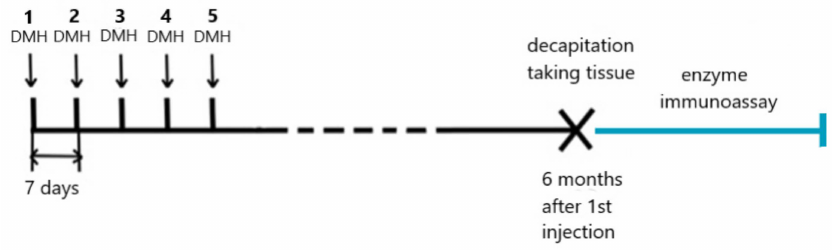
Figure 5. Design of experiment 1